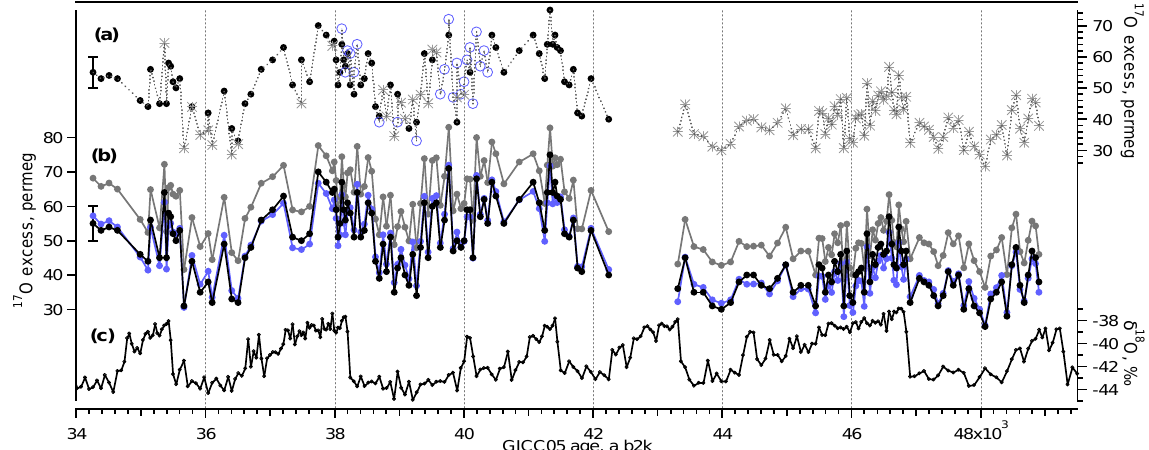
Figure 3. NEEM 17 O-excess (per meg) and δ 18 O (‰) data. (a) Comparison of the 17 O-excess data measured in spring 2011 (black dots), at the beginning of 2012 (blue circles) and in winter 2013/spring 2014 (grey stars). (b) Calibration of the 17 O-excess data. Grey dots: measured data; blue dots: one-point calibration; black dots: two-point calibration. (c) δ 18 O, ‰.